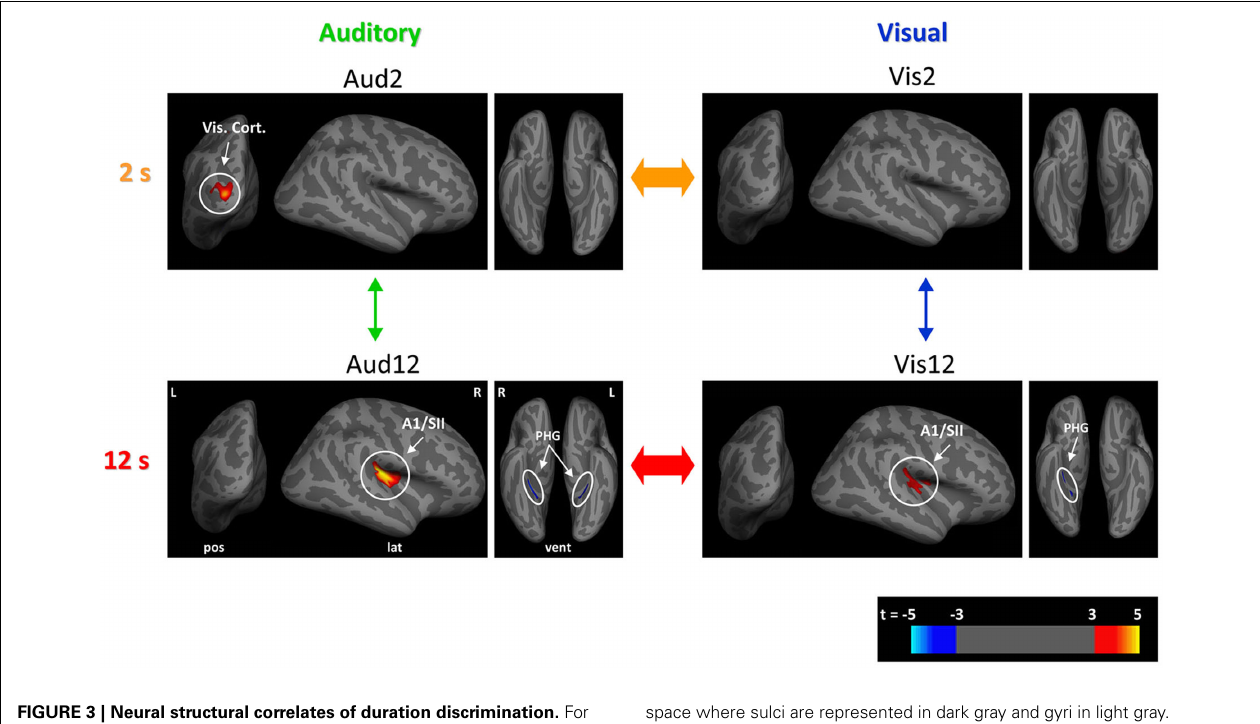
FIGURE 3 | Neural structural correlates of duration discrimination. For each of the experimental conditions, shown in red to yellow (blue) are those cortical loci where our analyses of cortical thickness revealed a significant positive (negative) correlation between cortical thickness and duration discrimination ( p < 0.05, corrected) across the group of participants ( n = 31). Aud2 (top left),Vis2 (top right), Aud12 (bottom left),Vis12 (bottom right). Data are shown overlaid onto an inflated template brain in a standard stereotactic